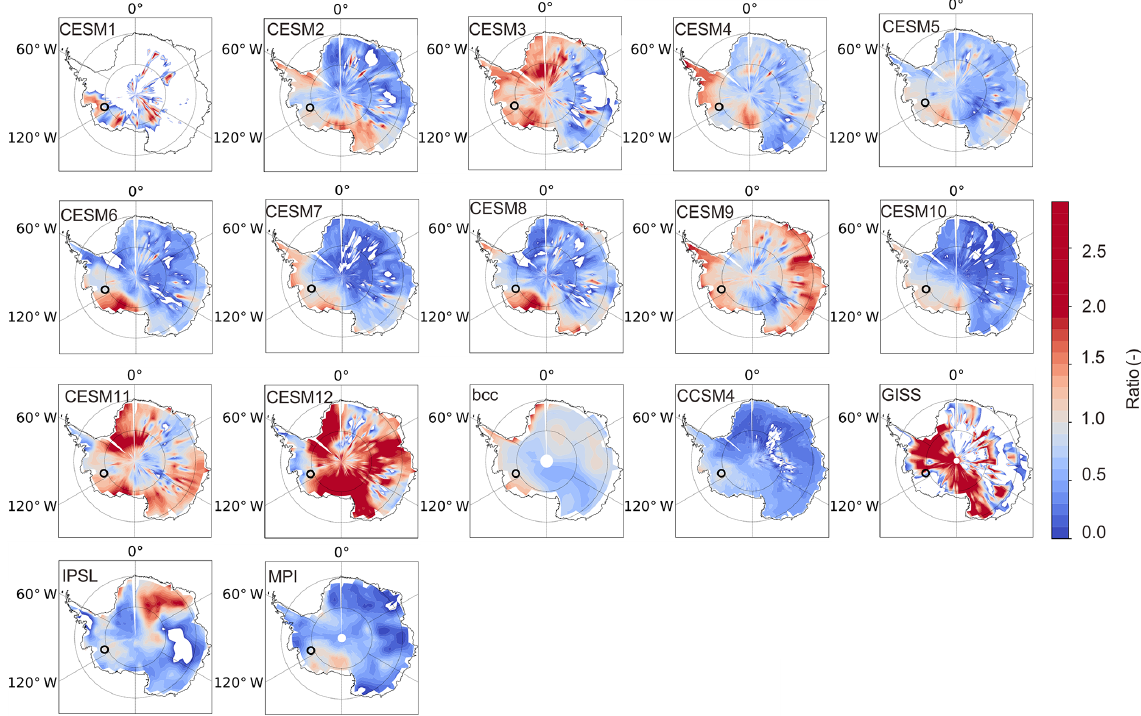
Figure 7. The ratio of the surface temperature trend (blue to red shaded area) from 1000 to 1600CE between other grid cells in Antarctica and WAIS. The black circle denotes the location of